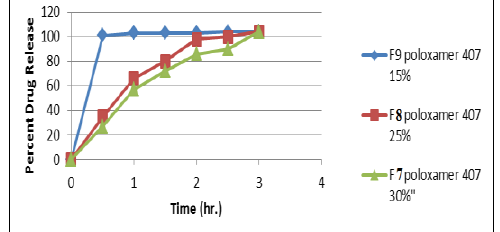
Figure 3: Effect of different poloxamer